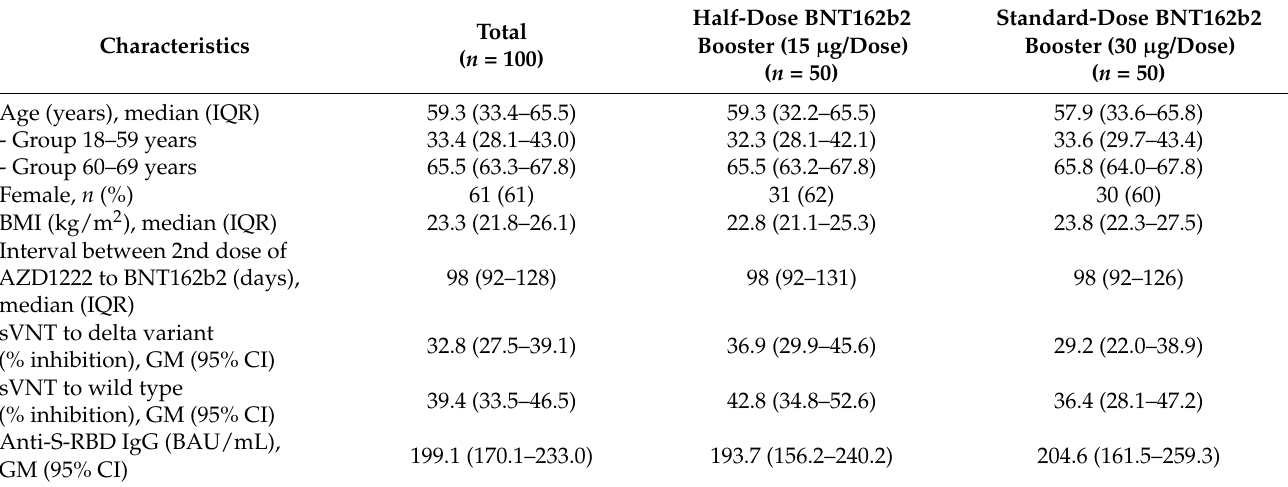
Table 1. Baseline characteristics of study